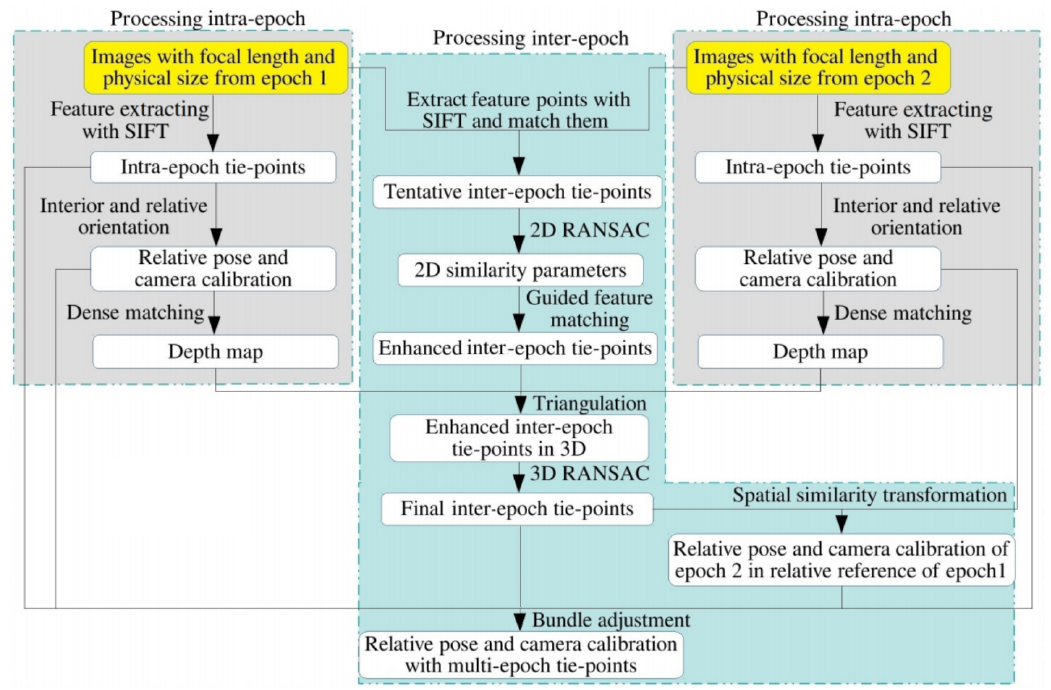
Figure 1. Our processing workflow. The inputs are marked in yellow, the blue area corresponds to the inter-epoch processing, and the gray is the intra-epoch processing. The input images had been resampled to the geometry of the fiducial marks prior to the